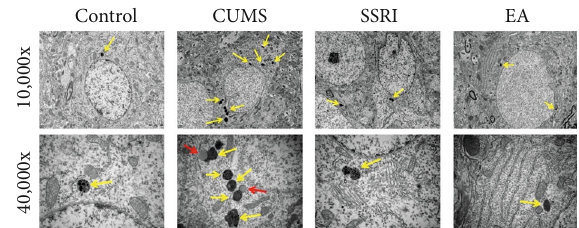
Figure 2: Number and size of autolysosomes in hippocampus CA1 neurons in each group (yellow arrows, autolysosomes; red arrows, autophagosomes; magni fi cation, 10,000 × (2 μ m) and 40,000 × (500nm)) ( n = 2 ).